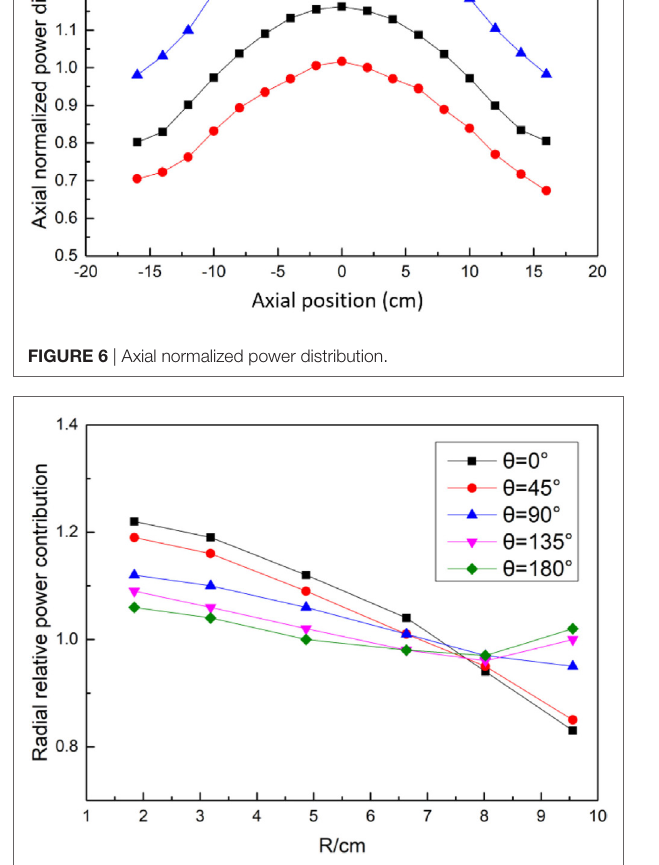
FigUre 9 | k eff versus time.